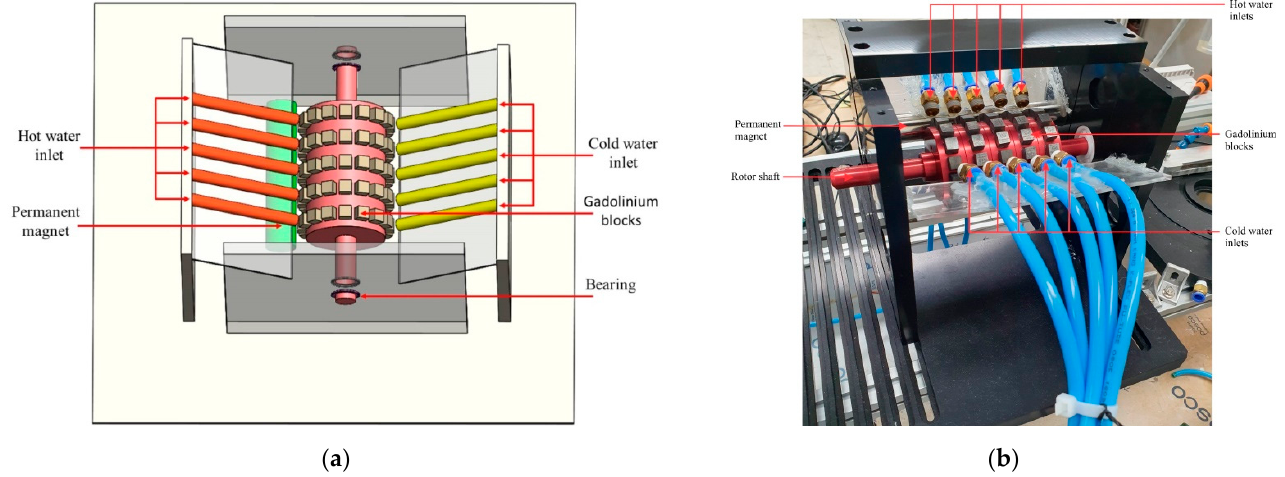
Figure 5. Schematic ( a ) and fabricated model ( b ) of extended version of thermomagnetic heat engine (cylindrical shape).